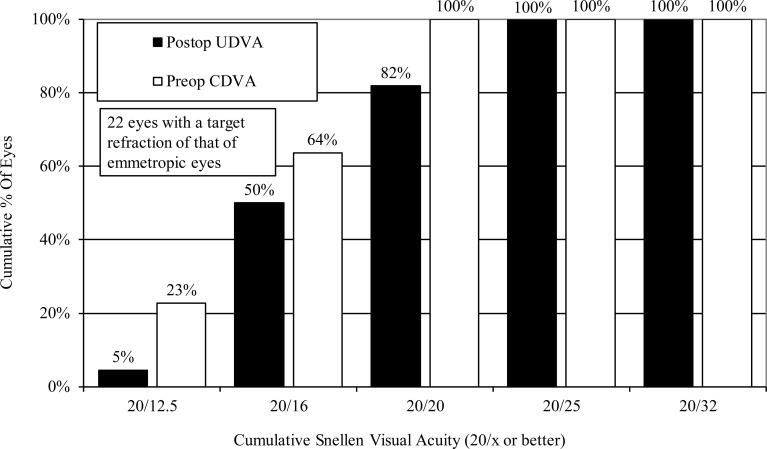
Changes in UDVA after implantation of an implantable collamer lens with a central hole.CDVA = corrected distance visual acuity, UDVA = uncorrected distance visual acuity.